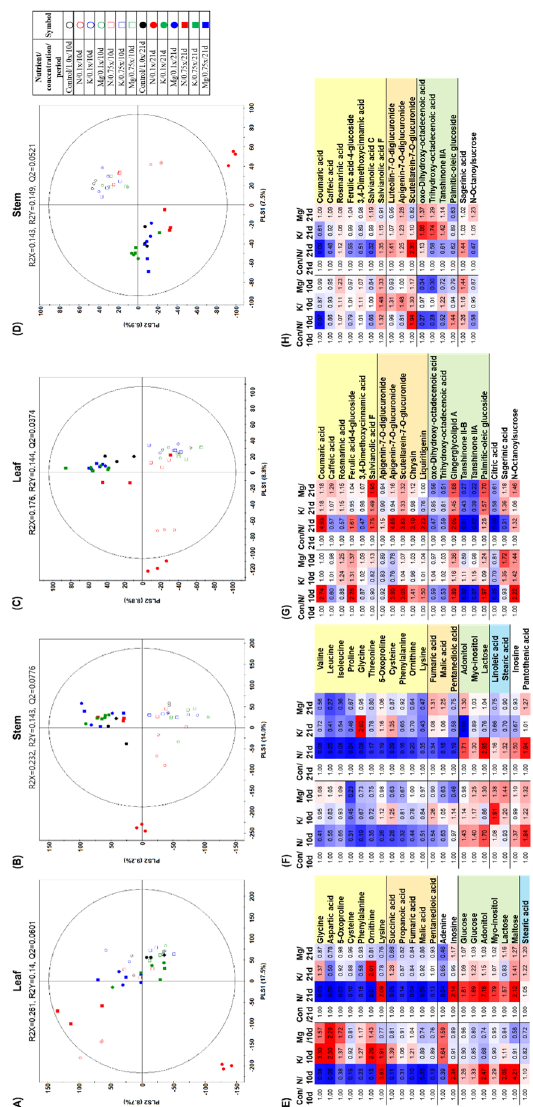
Figure 2. Partial least squares-discriminate analysis (PLS-DA) score plots derived from GC–TOF-MS datasets ( A , B ) and UHPLC–LTQ-MS/MS datasets ( C , D ) under different mineral supply conditions in Perilla frutescens . For the lowest mineral supply condition (0.1×), significantly altered metabolites (VIP > 1.0 and p -value < 0.05) are represented by fold change from GC–TOF-MS datasets for leaves ( E ) and stems ( F ) and UHPLC–LTQ-MS/MS datasets for leaves ( G ) and stems ( H ). Con: control; N: nitrogen; K: potassium; Mg: magnesium.